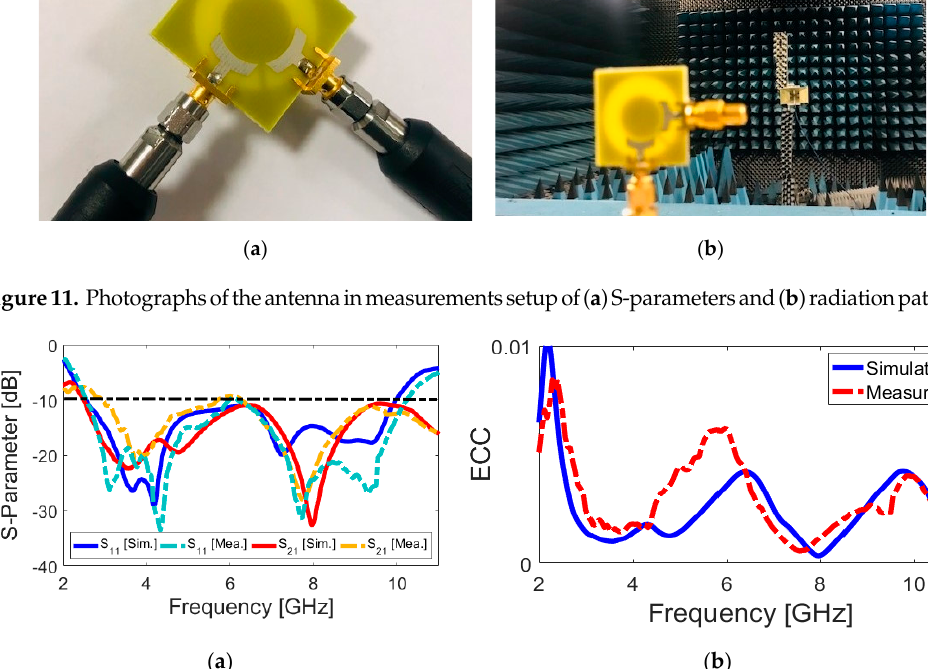
Figure 12. Measured and simulated ( a ) S ‐ parameters and ( b ) ECC results of the proposed antenna.